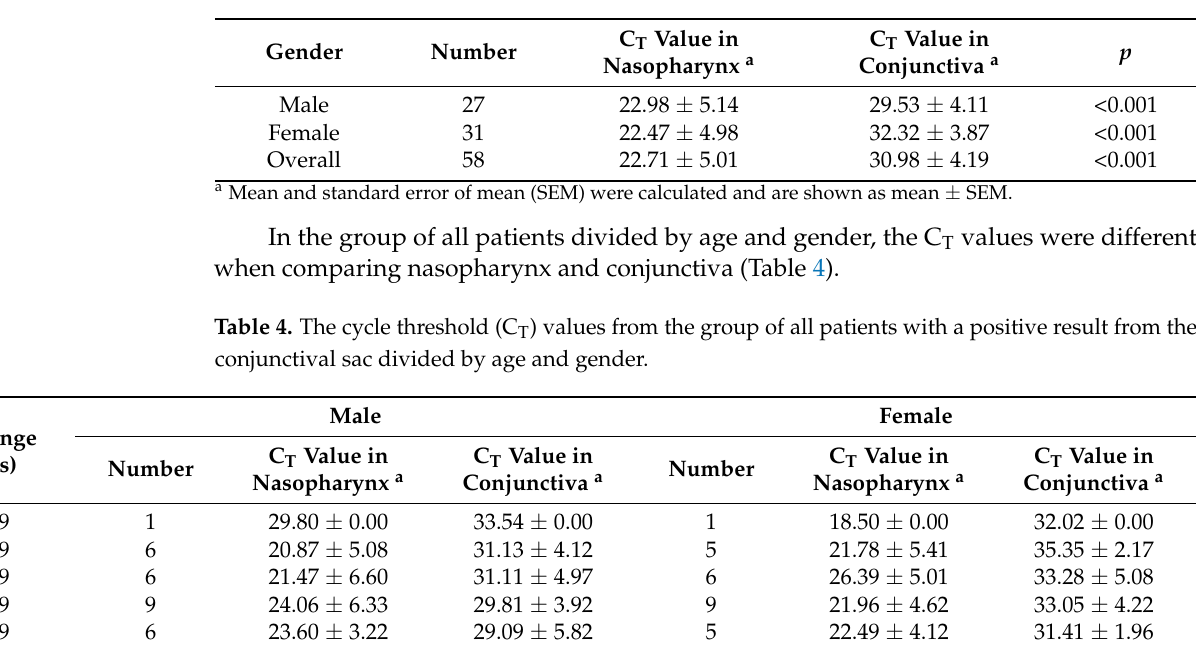
Table 3. The cycle threshold (C T ) values from the group of all patients with positive result from the conjunctival sac.